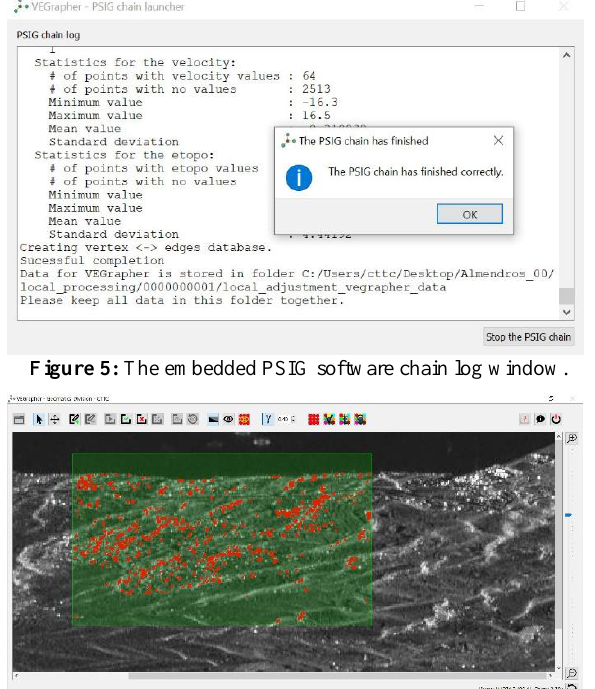
Figure 6: Reviewing the results obtained after reprocessing a local